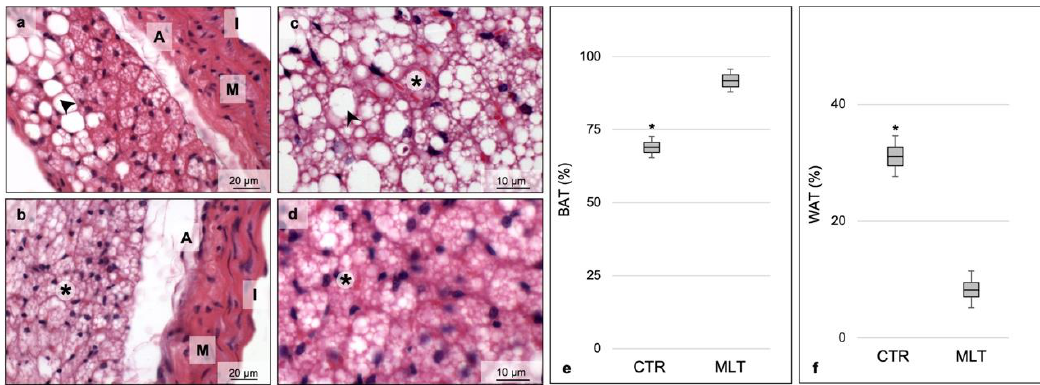
Figure 1. Morphometrical evaluation. Photomicrographs of the aorta from the control ( a , c ) and MLT-treated ( b , d ) mice. Each panel shows a full-field image at 400 × ( a , b ) (scale bars: 20 µ m) and at 1000 × ( c , d ) (scale bars: 10 µ m). Control group aorta showed larger areas of WAT, characterized by white lipid drop, with a minimum presence of multilocular brown adipocytes. In addition, ApoE - / - mice aorta is also characterized by a disarrangement of normal vascular structure ( a ). On the contrary, MLT-treated mice showed a higher presence of BAT, with a significant reduction of white adipocyte infiltration and are also characterized by relatively unremarkable changes in vascular cytoarchitecture and organization ( b ). Photomicrographs of perivascular adipose tissue from the control ( c ) and from treated ( d ) mice. Graphs summarize the morphometrical analyses of the percentage per area of periaortic BAT ( e ) and WAT ( f ) obtained evaluating, for each experimental animal, fifteen non-overlapping fields with the same area. Statistical analyses comparing multiple continuous outcomes were performed using one-way analyses of variance test corrected by Bonferroni for morphometrical evaluations. Continuous variables are summarized as means ± standard deviation. Error bars represent the 95% confidence interval around the mean; * indicates the level of significance, p ≤ 0.05; black asterisk indicates BAT, brown adipose tissue; black arrowhead indicates WAT, white adipose tissue; I, tunica intima; M, tunica media; A, tunica adventitia; CTR, control group; MLT, mice treated with melatonin.